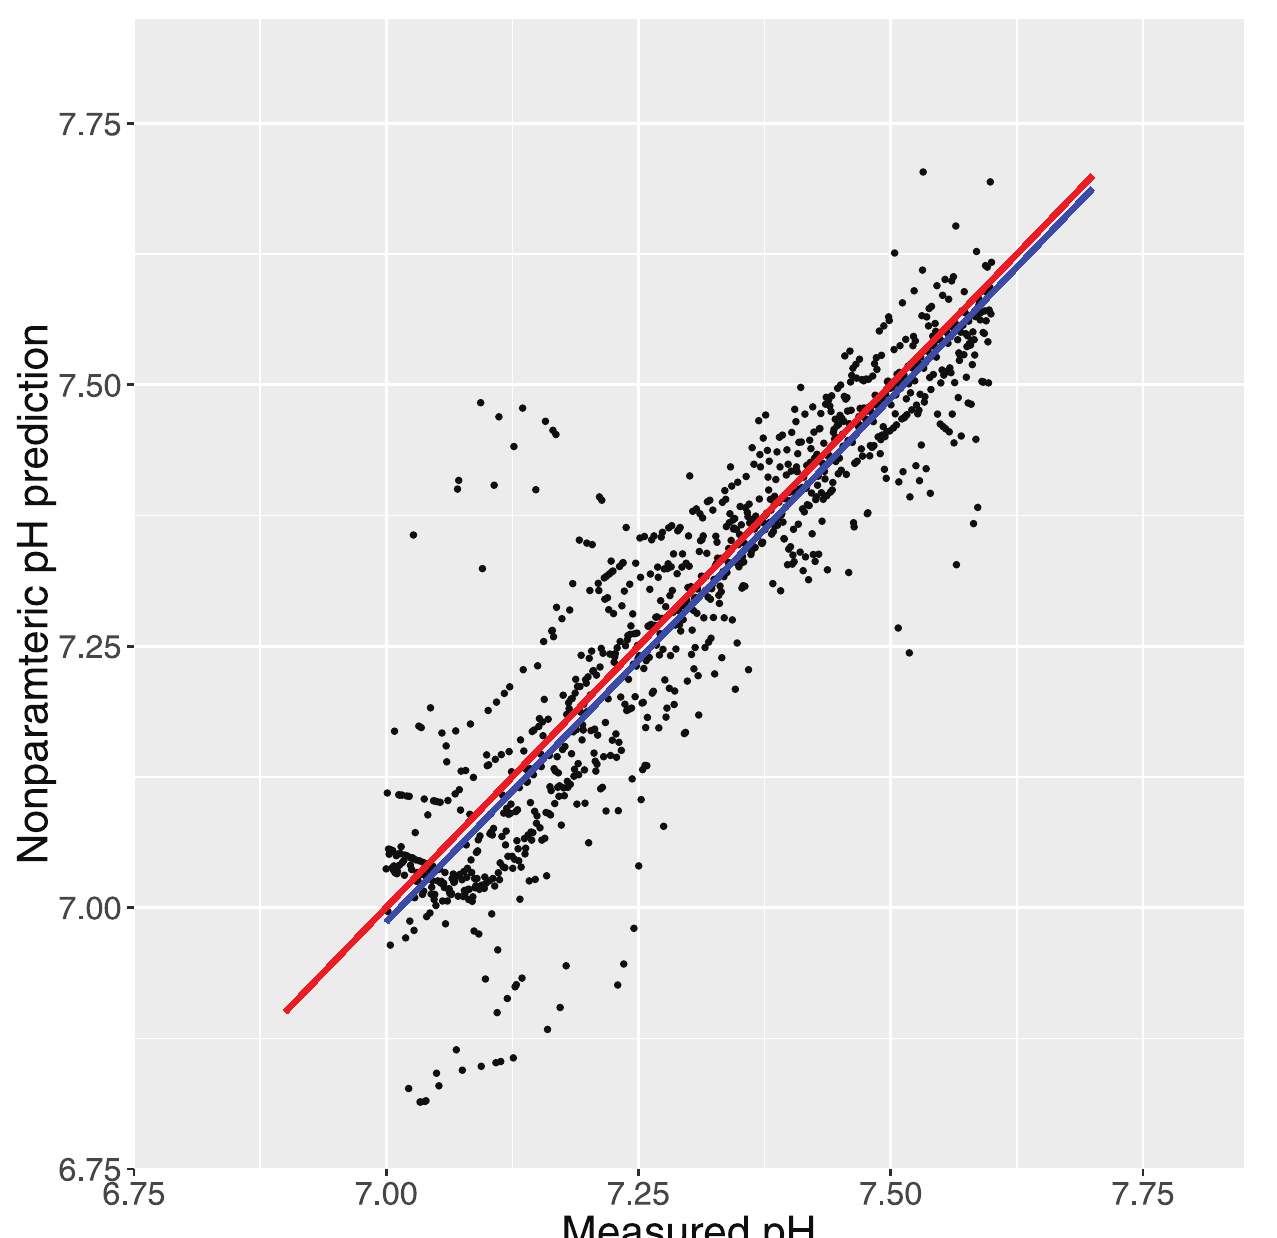
Fig 5. Fig 5 shows the prediction obtained by unbiased nonparametric regression (blue line) in comparison with the line of identity (red).